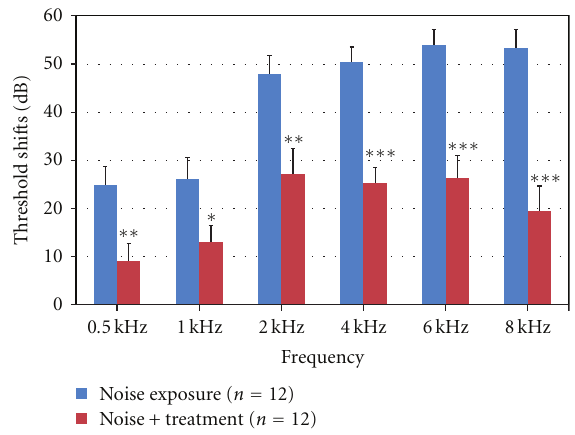
Figure 1: Average ABR threshold shifts at each frequency (0.5– 8kHz) 10 days after noise exposure. Hearing threshold shifts were found in both the noise exposure and the noise/treatment groups at all frequencies with greater shifts in the high frequencies (2–8kHz). Compared to the noise exposure group, significant reductions in threshold shifts were found in the noise/treatment group at all frequencies. There are significant di ff erences in the threshold shifts between the noise exposure and the noise/treatment groups at all frequencies, especially at high frequencies ( ∗∗∗ , ∗∗ , and ∗ indicate P < 0 . 001, < 0 . 01, and < 0.05, resp. Error bars represent standard error of the means. Number of ears = 12 in each